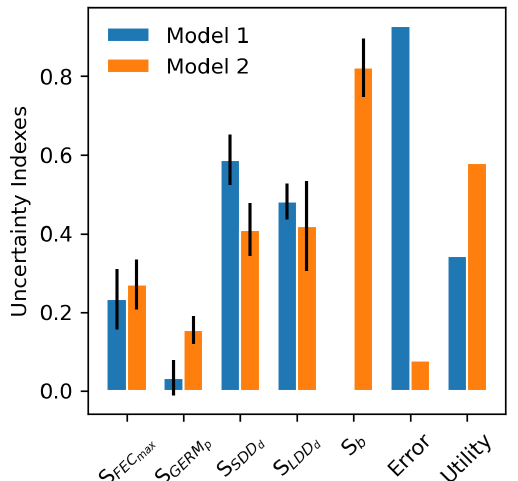
Figure 7. Comparison of parameter-specific sensitivities, model er- ror and utility between two structures of the migration module of LPJ-GM. Model structures refer to seed dispersal simulated ei- ther with a linear combination of two negative exponential kernels across species (Model 1: “default kernel”) or of species-specific fat-tailed kernels (Model 2: “fat-tailed kernels”) (see Eq. A3). S b : model sensitivity to the shape parameter b of fat-tailed kernels (see Table 2 for the description of other parameters). Note that the kernel formulation of Model 1 has no shape parameter (hence, S b is NA). See Sect. 2.6.2 for the calculation of model